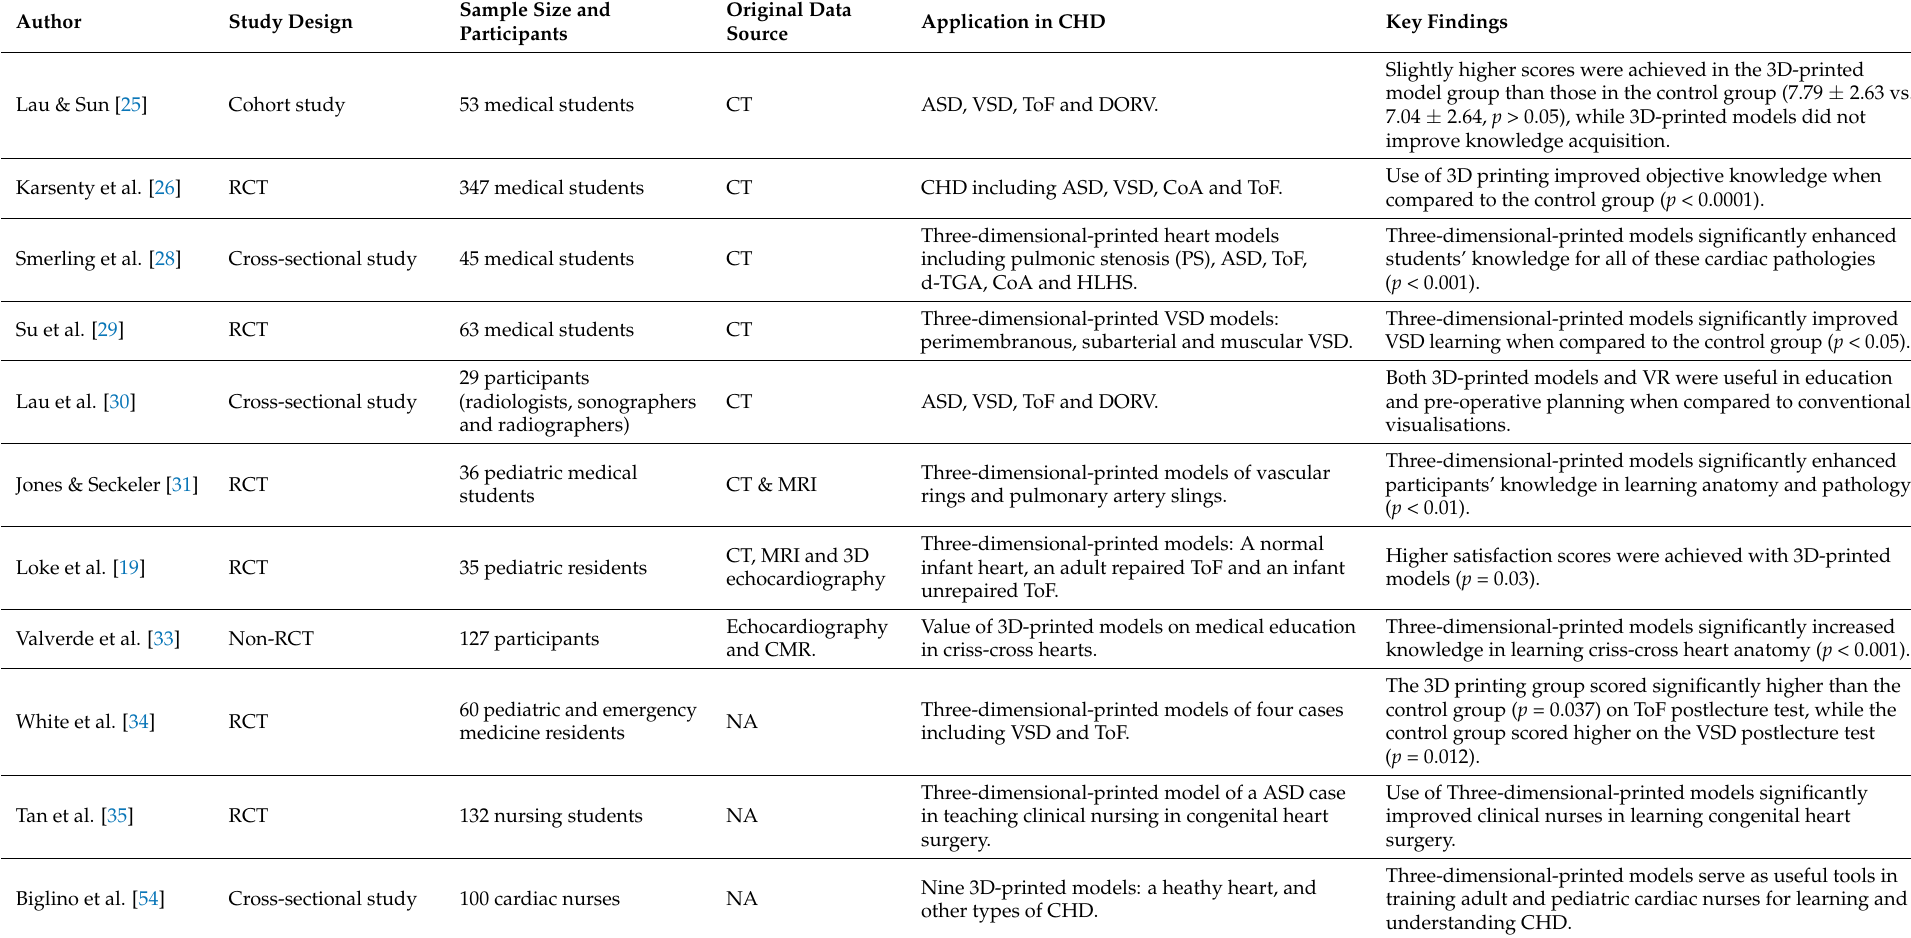
Table 2. Application of 3D-printed models in medical and clinical education. Modified from Sun and Wee